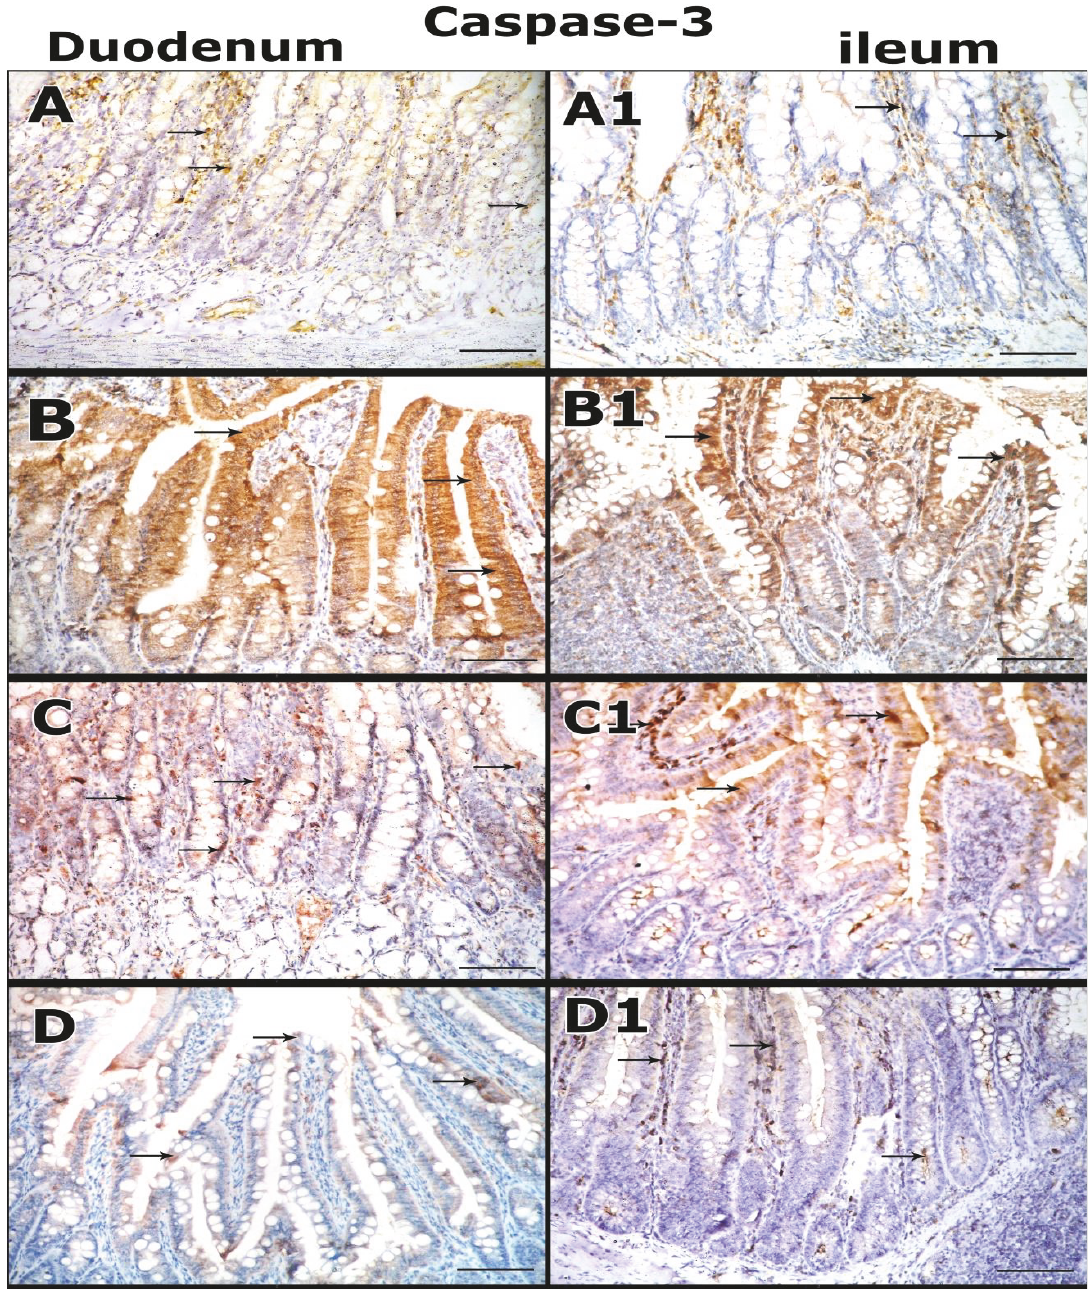
Figure 3: Immunohistochemical staining micrographs of intestinal tissues (duodenum and ileum) of the studied groups for Caspase 3 reactivity ( arrow ). A, A1: Control group section shows few weak Caspase-positive cells. B, B1: iron overload group section shows numerous strongly positive cells. C, C1: Iron +DFO group section shows decrease of caspase-3 reactivity. D, D1: Iron+ Quercetin group section shows that marked reduction of the Caspase reactivity in most cells or few strong positive cells is detected (immunoperoxidase, haematoxylin counter-stain